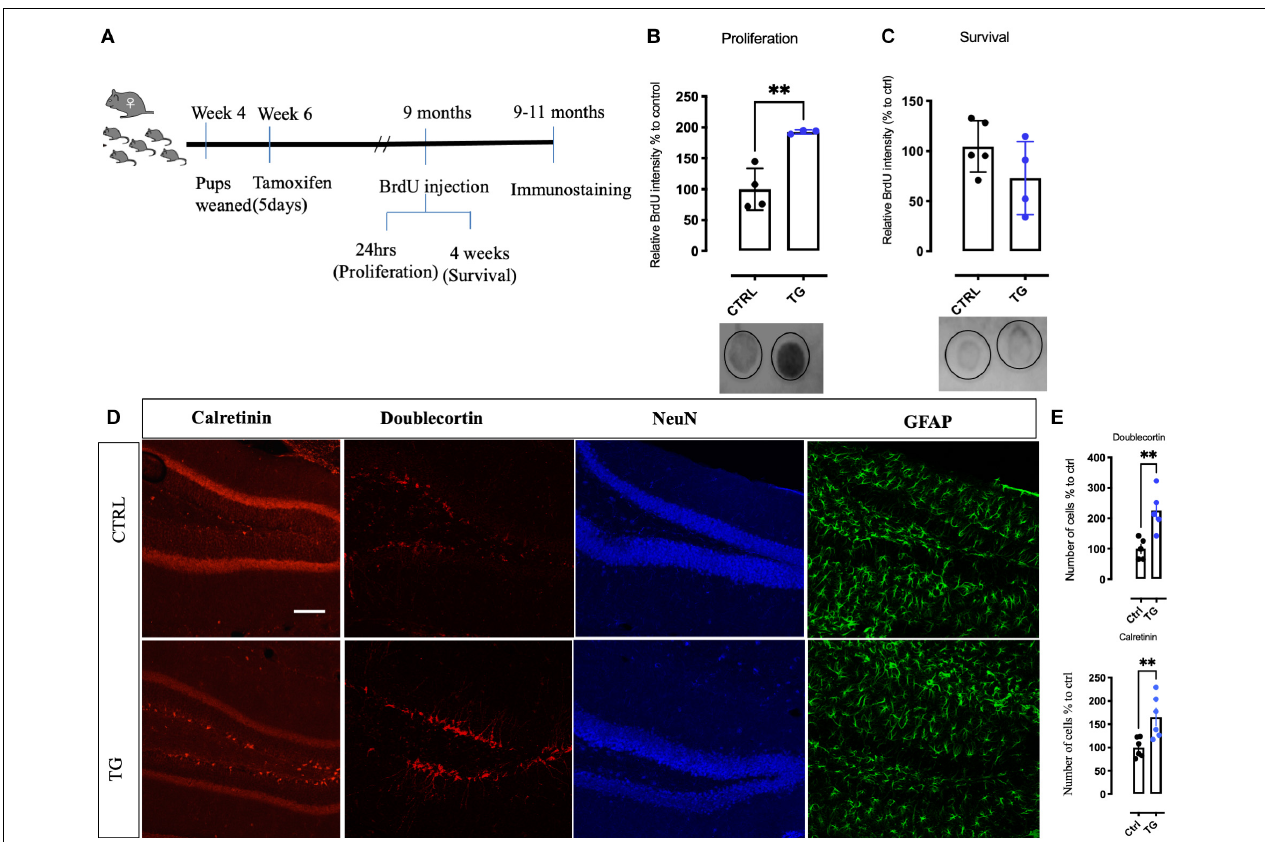
FIGURE 4 | Increased new born precursor cells and altered neuronal markers in the hippocampus of the transgenic mice. (A) A schematic representation of time points for BrdU injection to study proliferation and survival of hippocampal neurons. (B) Quantitation of new-born neurons with BrdU incorporation in the transgenic animals by dot-blot. In samples collected for proliferation, TG animals showed a robust increase. (C) In the survival samples, no difference in BrdU incorporation was observed in both the groups. (D) Markers for different stages of neurogenesis was studied in both the groups. In the DG of the HC, DCX, and Calretinin was increased in the transgenic animals, however, NeuN and GFAP immunoreactivity was found to be unaltered. (E) Quantitative analysis of the neurons for DCX and Calretinin shows significant increase in the TG animals. Scale bar represents 100 µ m, N = 4/group, Unpaired t -test ** p -value < 0.01. Error bars represent Means ± SEM. HC-Hippocampus, DCX-Doublecortin, DG-Dentate